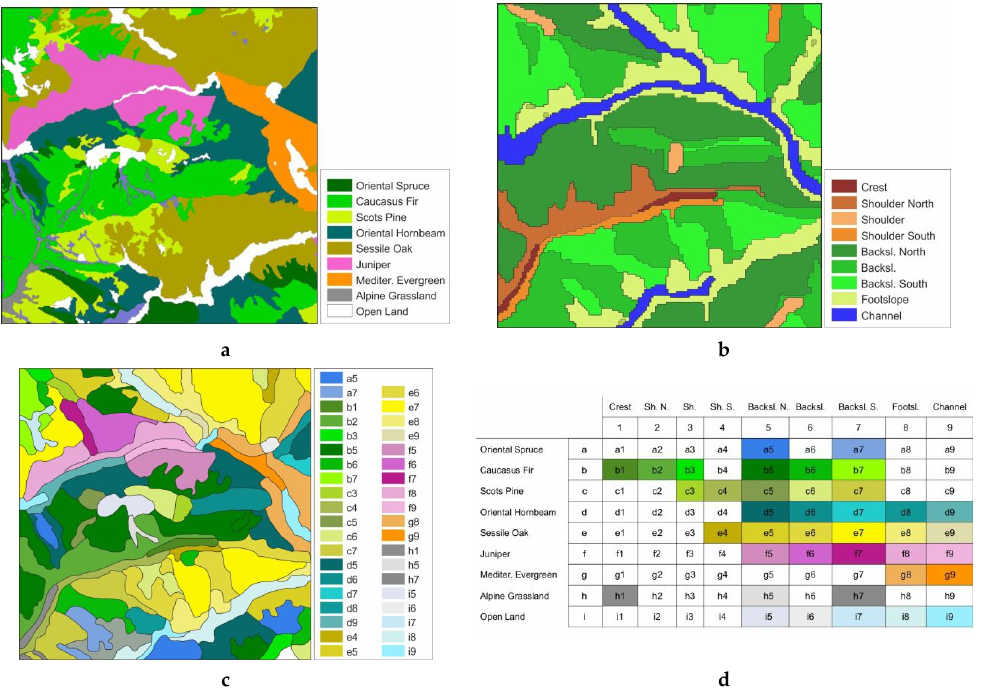
Figure 9. ( a ) Landcover classes; ( b ) Landform classes (level ii); ( c ) Landform/Landcover assemblages; ( d ) look-up table with colors for the Landform/Landcover assemblages.